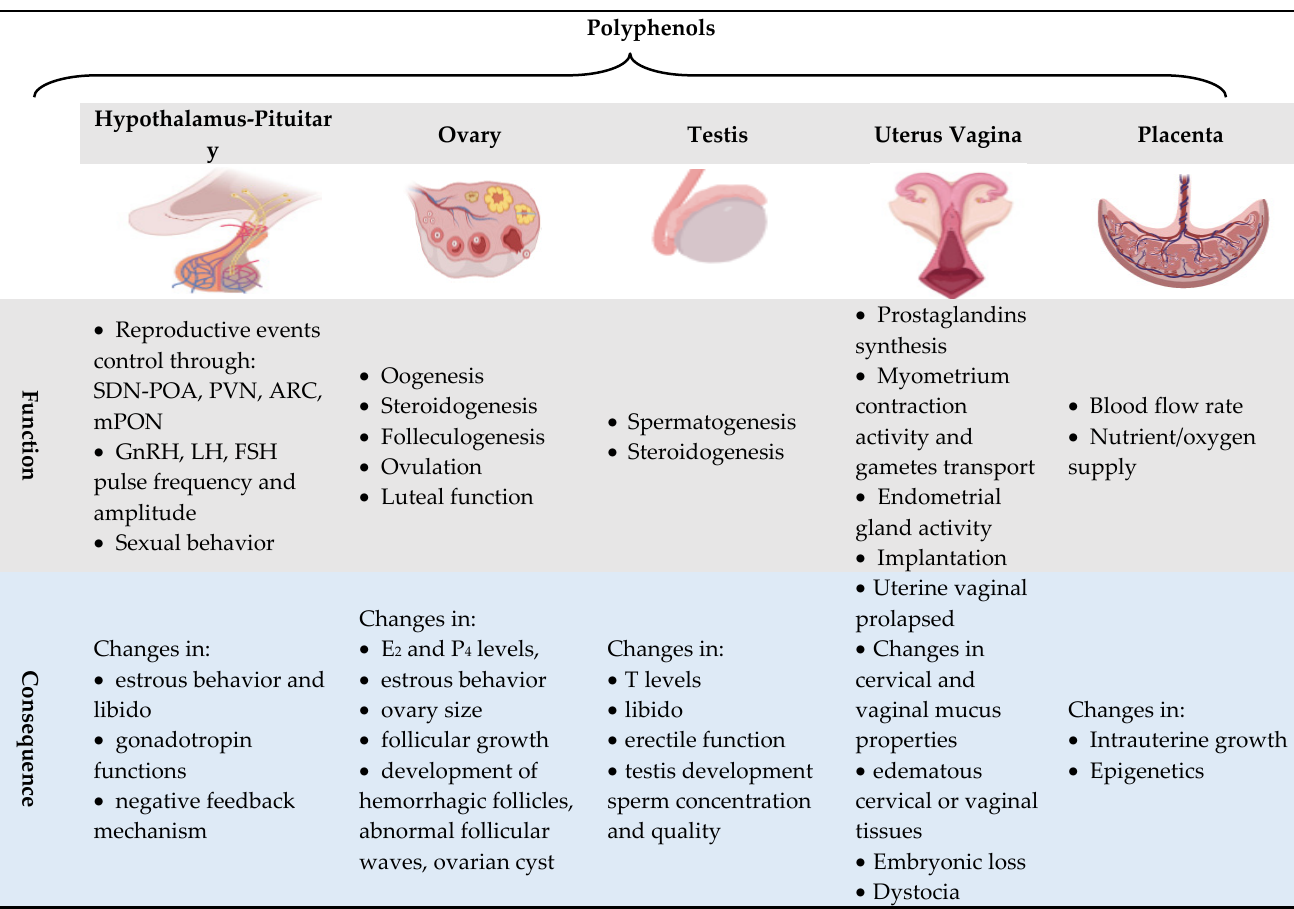
Figure 2. Effects of polyphenols on functions of reproductive organs and its consequences. Figure 2. E ff ects of polyphenols on functions of reproductive organs and its consequences. Abbreviation: sexually dimorphic nucleus of the preoptic area (SDN-POA), paraventricular nucleus (PVN) arcuate nucleus (ARC), medial pre-optic area (mPOA), gonadotropin-releasing hormone (GnRH), luteinizing hormone (LH), follicle-stimulating hormone (FSH), estradiol (E 2 ), progesterone (P 4 ), testosterone (T). Changes refer to: positive or negative e ff ects